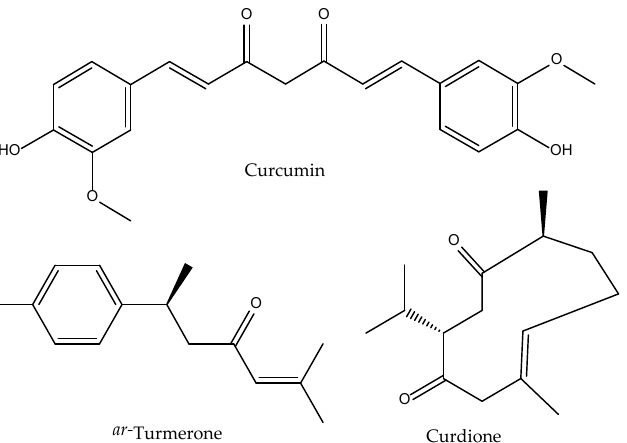
Figure 9. Bioactive anti-inflammatory (eicosanoid inhibition) and antioxidant principles from Curcuma aromatica .